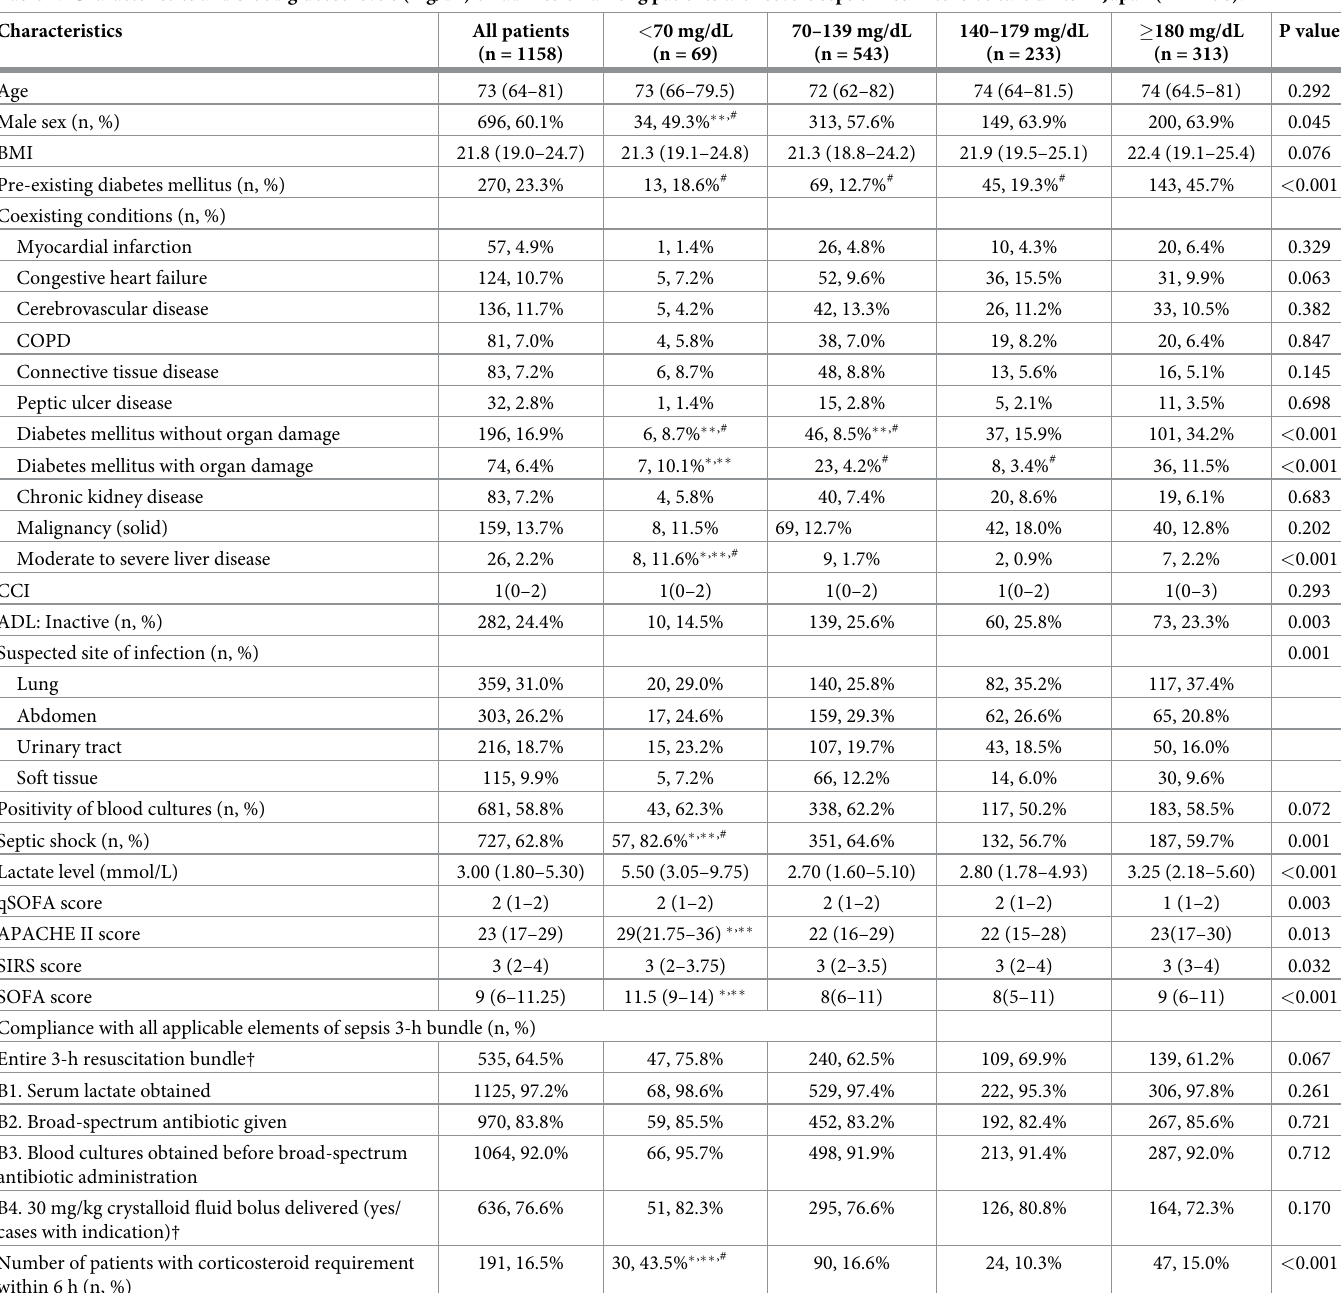
Table 1. Characteristics and blood glucose levels (mg/dL) on admission among patients with severe sepsis in 59 intensive care units in Japan (n = 1158).